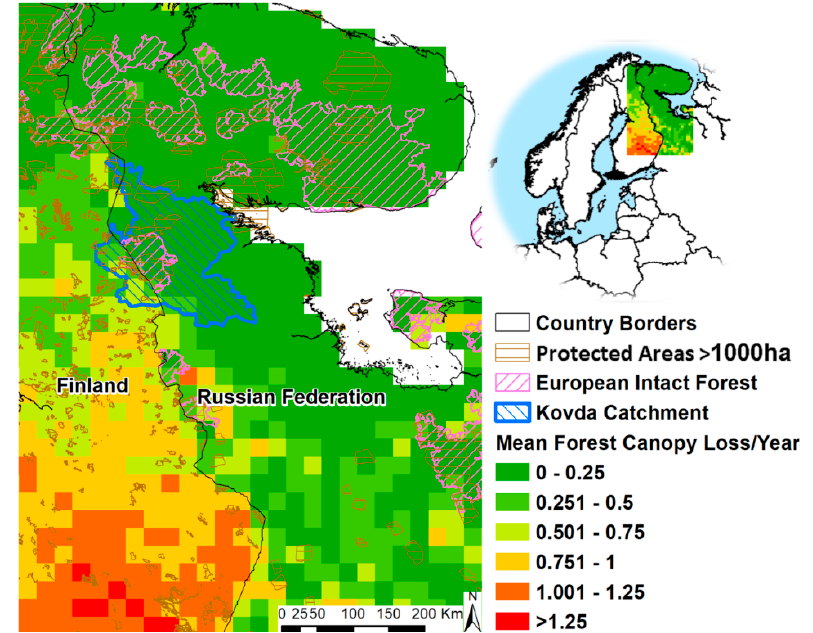
Figure 3. Map showing mean forest canopy loss 2000–2018 [60] using a 25 × 25 km grid, with protected areas larger than 10 km 2 (data from the website protectedplanet.net) and remaining intact forest [50]. It should be noted that for the Russian area there were only two protected areas < 10 km 2 , both located North of the Kovda River catchment. Note that the protected area borders are